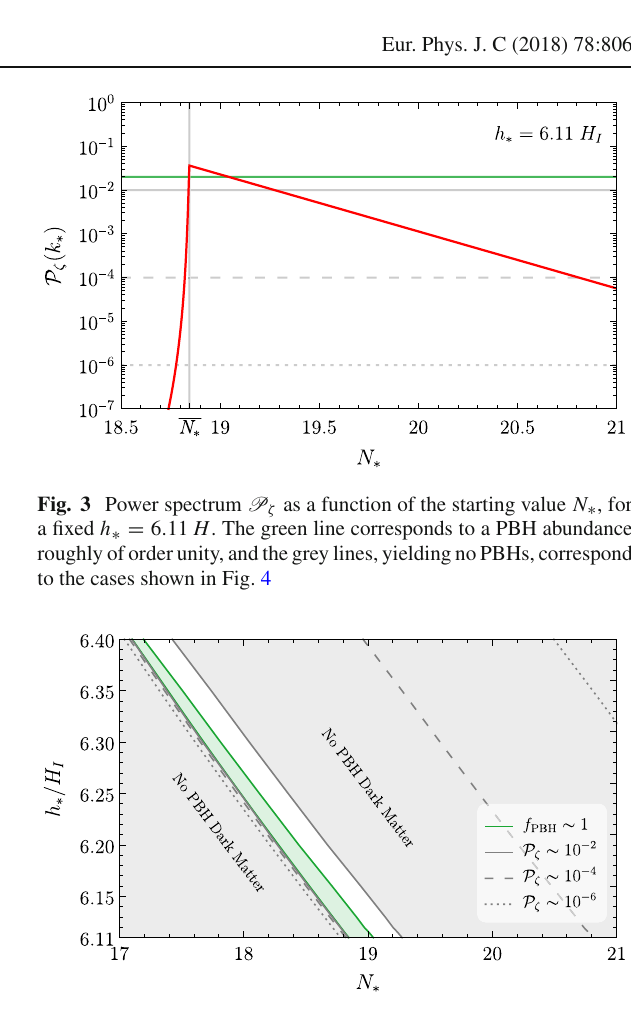
Fig. 4 Power spectrum P ζ as a function of the starting values N ∗ , h ∗ . The grey regions do not yield PBHs, and the green region corresponds to a non-negligible PBH abundance